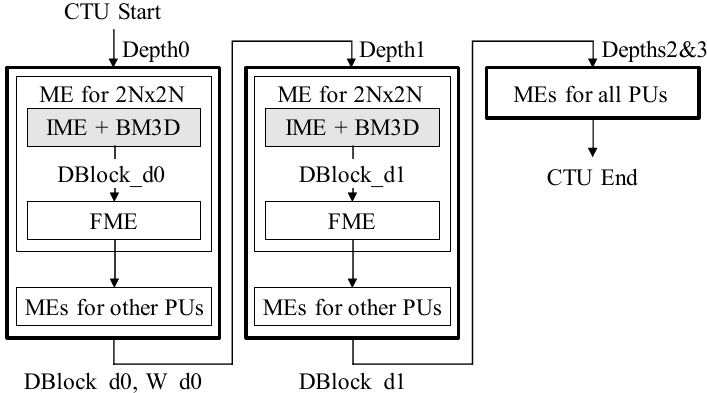
Figure 1. High-efficiency video coding (HEVC) encoding flow combined with block matching three-dimensional collaborative filtering (BM3D). CTU: coding tree units; ME: motion estimation; IME: integer ME; FME: fractional ME; and PUs: prediction units.